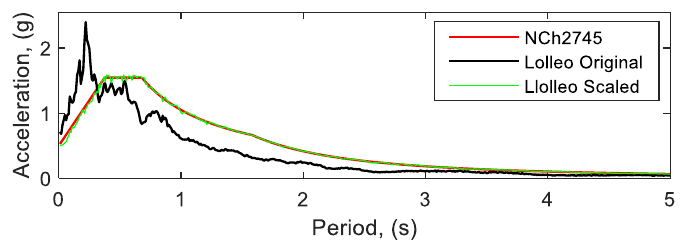
Figure 6. Design spectrum of NCh2745 for type soil III, seismic zone 3 and 5% critical damping. The response spectra of the original and scaled frequency domain recording are overlaid to fit the design spectrum.